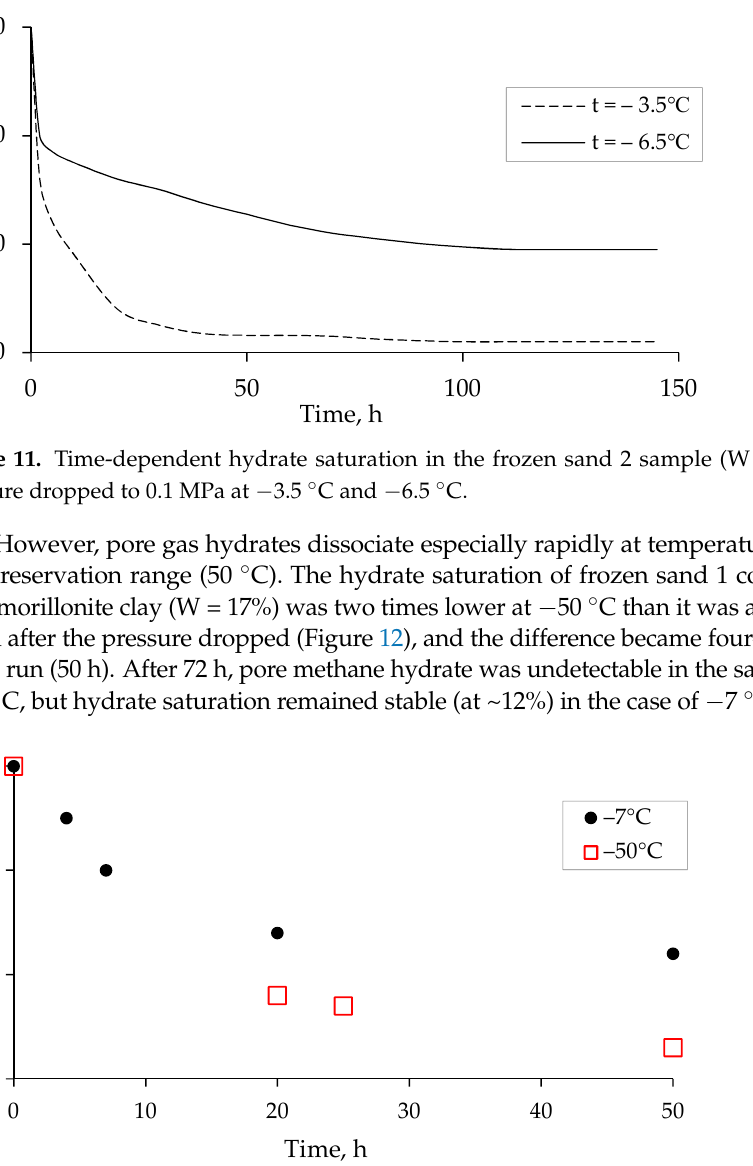
11 of 18 Figure 10. Time-dependent hydrate saturation in saline (Z = 0.2%) and nonsaline (Z = 0.01%) sand 1 samples (W = 10%) after the pressure dropped to 0.1 MPa at −6 ℃ . 3.5. Temperature